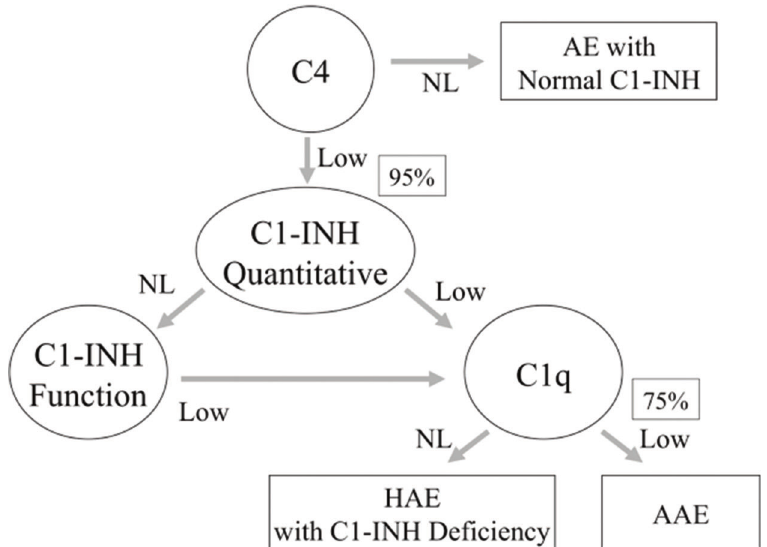
Figure 3 - Algorithm of HAE